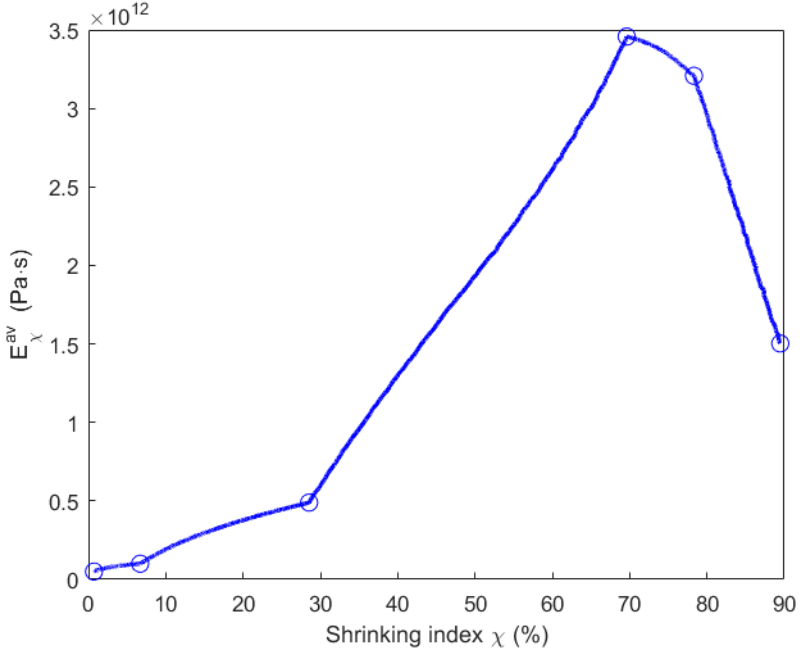
av E χ with respect to the shrinking index. Figure 23. Evolution of the parameter E av χ with respect to the shrinking index.